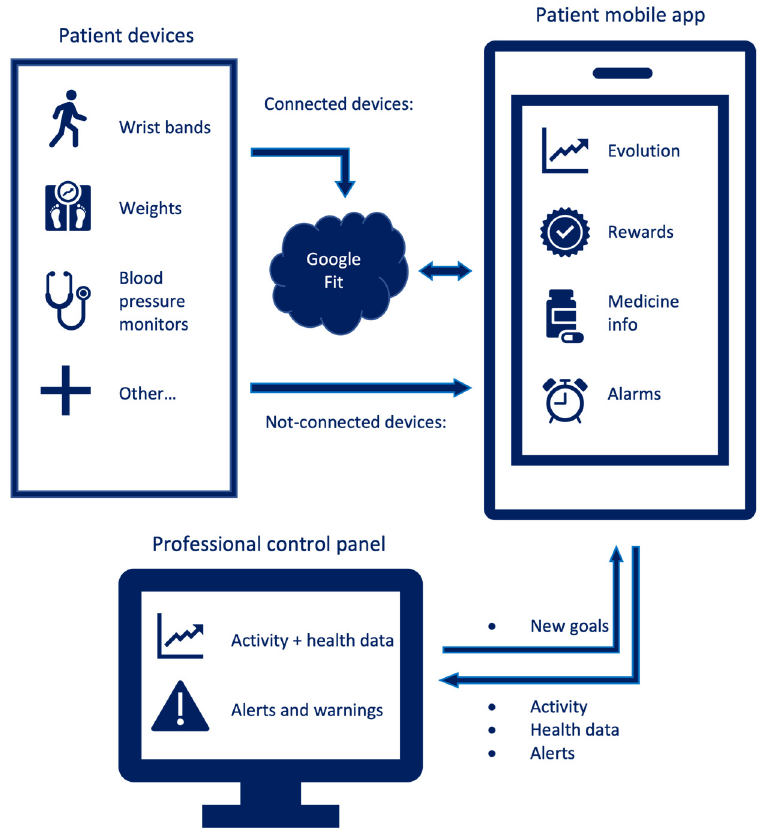
Figure 1. Architecture of the TeleHealth system.